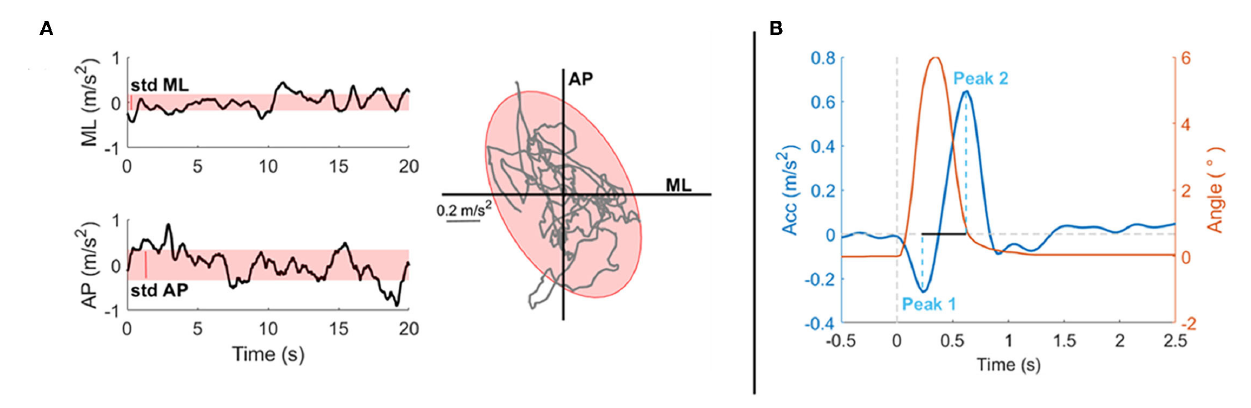
FIGURE 3 | Experimental data from a representative subject to explain the parameters selected for the analysis of the proposed tasks. Parameters are based on readings of an Inertial Measurement Unit (IMU) placed on the sternum of the subject, i.e., parameters are extracted from the acceleration measures. (A) On the first column, the stabilograms (black line) and the variability (red shaded area, STD) of a 20-s exercise both in the ML (up) and AP (bottom) directions are shown. In the second column, the statokinesigram (gray line) together with the fitted confidence ellipse (red shaded area) representing the sway area are shown. Those parameters are computer for tests 1, 2, 3, and 4. (B) This panel shows the postural response after a perturbation of a representative subject for test 5: in red the perturbation trajectory, in blue the postural response along the perturbation’s direction. Here, the peaks amplitudes are highlighted (light blue dashed line) together with the peak-to-peak time difference (black